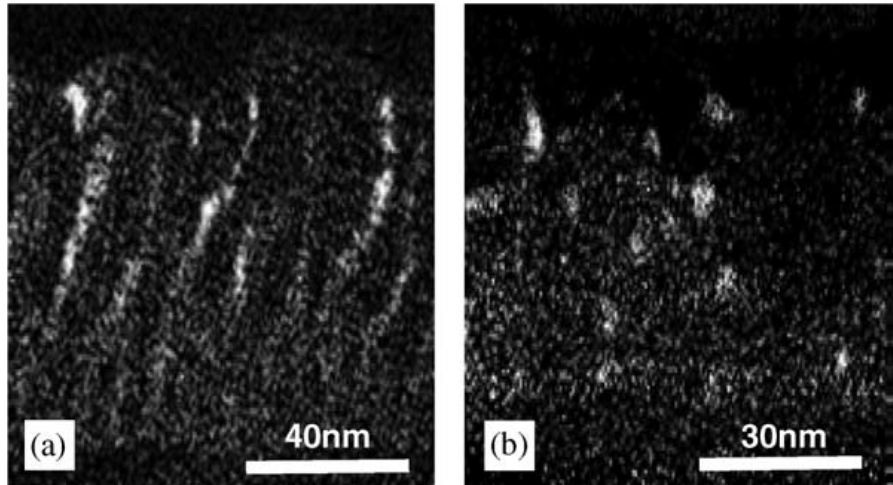
Figure 11. Energy filtered TEM showing the Cr nanoaggregation into the columnar morphology in AlCrN with 4% Cr prepared at two fabrication temperatures: ( a ) 700 ◦ C, and ( b ) 800 ◦ C. Reproduced with permission from Reference